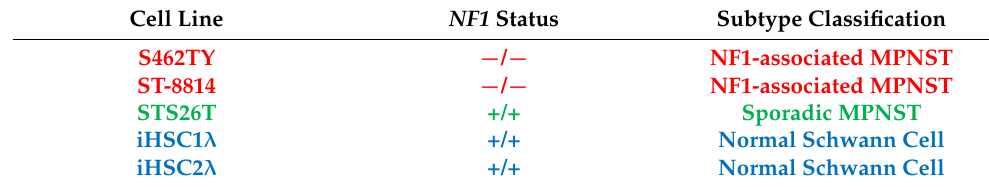
Table 1. In vitro cell models are annotated by NF1 status and classification.